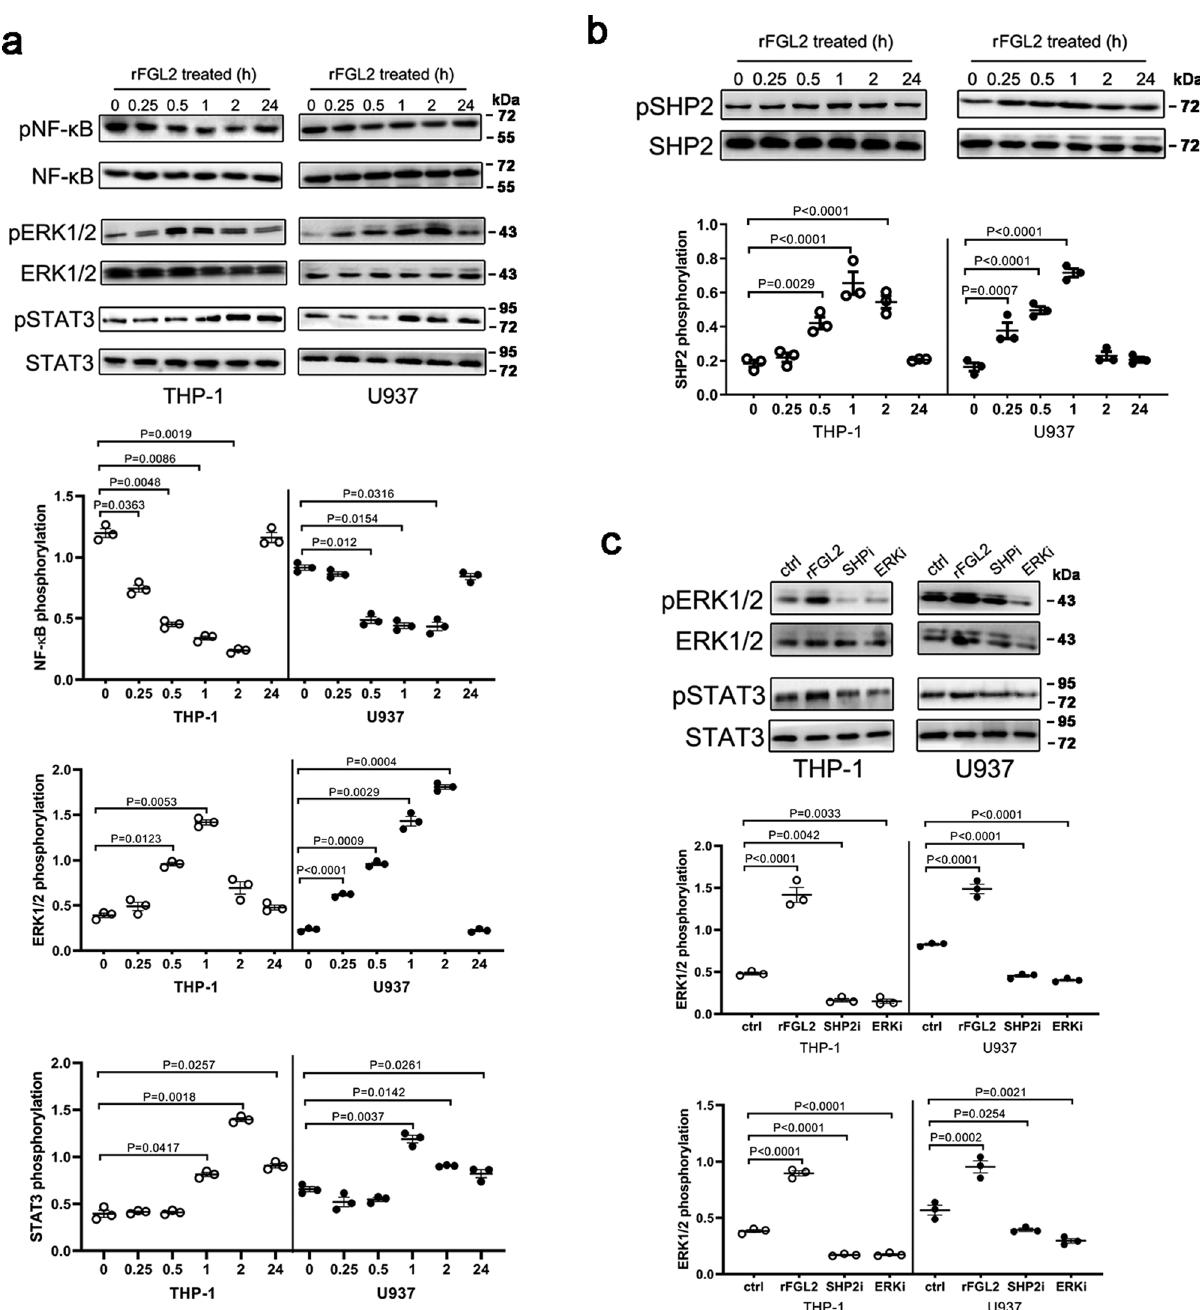
Fig. 6 FGL2 induced pro-repair macrophages polarization through the suppression of the NF- κ B signaling pathway and the activation of the SHP2- ERK1/2-STAT3 signaling pathway. THP-1 and U937 cells were treated with rFGL2 ( a , b ) or SHPi/ERKi ( c ). The phosphorylation levels of NF- κ B, ERK1/2, STAT3, and SHP2 in THP-1 and U937 cells were determined by western blot ( a – c ). Data represent the mean value ± SEM of three individual experiments ( n =